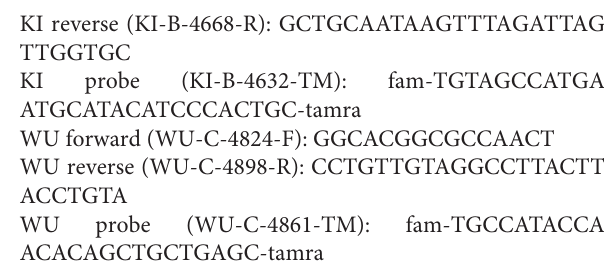
Patients not requiring IVF Patients requiring Unadjusted Adjusted ( n = 139) IVF ( n = 62) comparisons